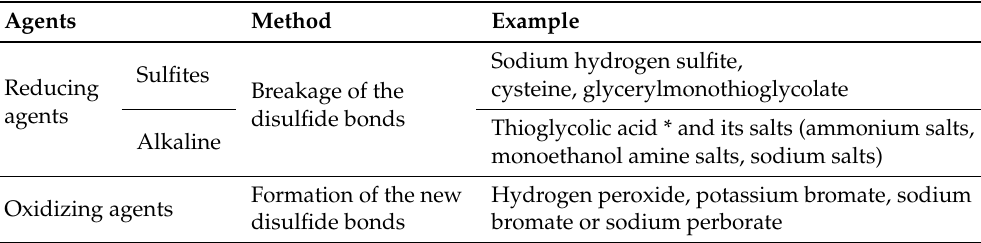
Table 4. Hair waving agents